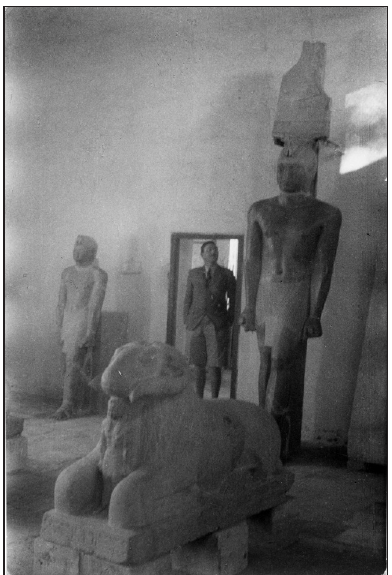
Figure 1: Anthony Arkell at Meroe